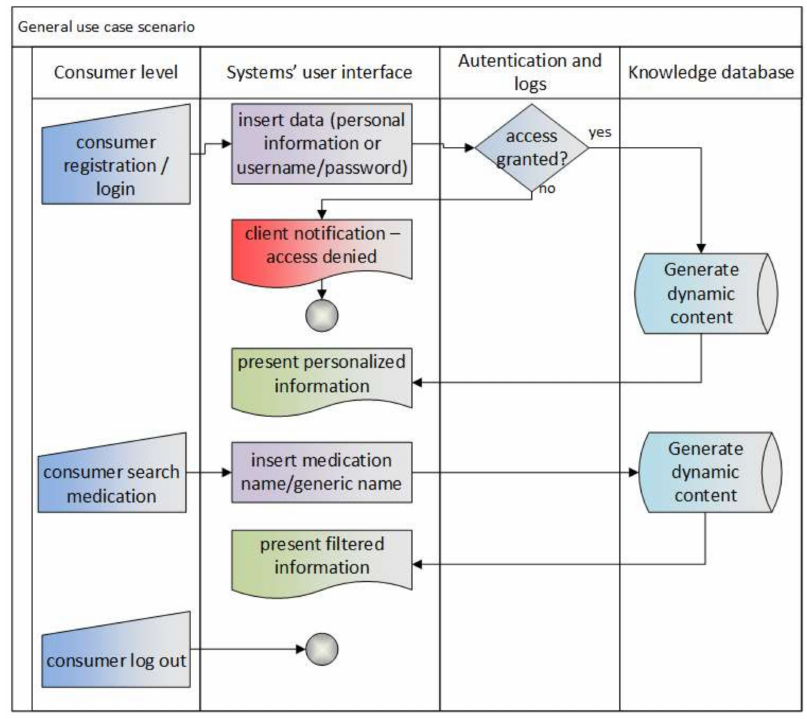
Figure 3. MyMediMan’s general use case